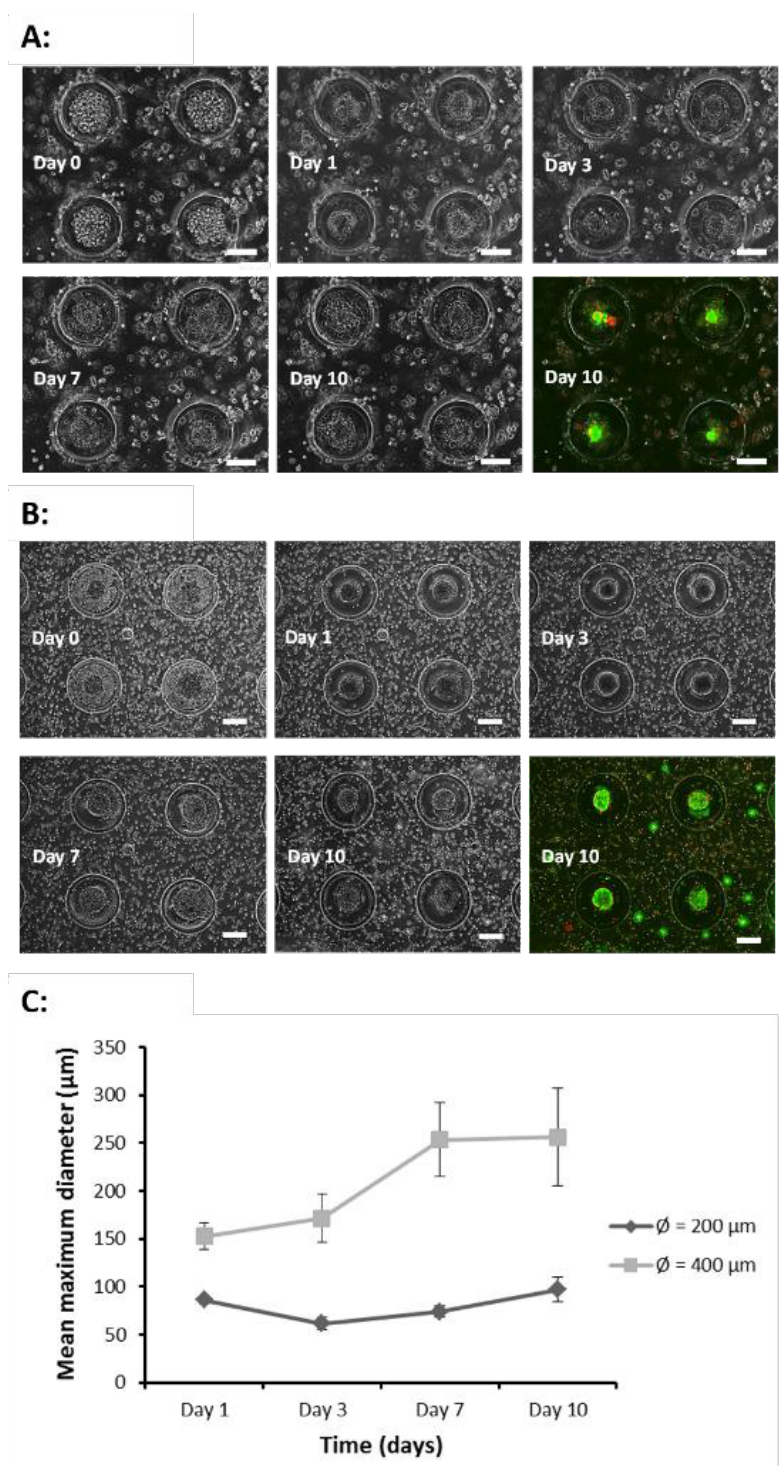
Figure 6. Co-culture of DPSCs and HaCaT cells. Days 0 to 10 represent images of cells in microwells at the same location. Day 0 images indicate successful localization of HaCaT cells within the microwells. Cell aggregates were formed by day 1 and persisted up to day 10. The day 10 image represents the fluorescence images of the live/dead assay. Green fluorescence indicates live cells while red fluorescence indicates dead cells. Scale bars represent 100 μm in ( A ) design 1 and 200 μm in ( B ) design 2. ( C ) Cell aggregate diameter over time.